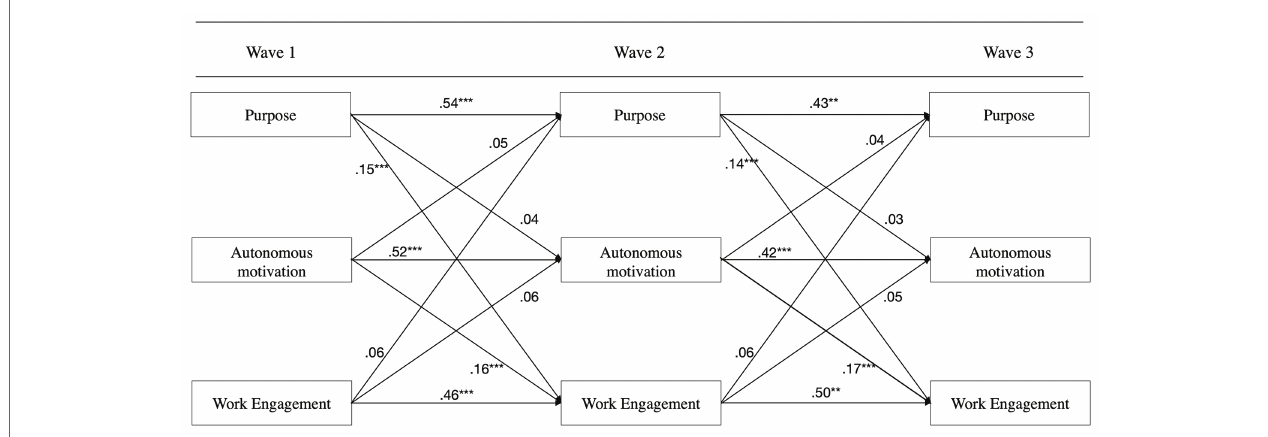
FIGURE 4 | The crossed paths indicate directionality from purpose to engagement and from motivation to engagement. The crossed relationship between purpose and motivation is positive but nonsignificant.